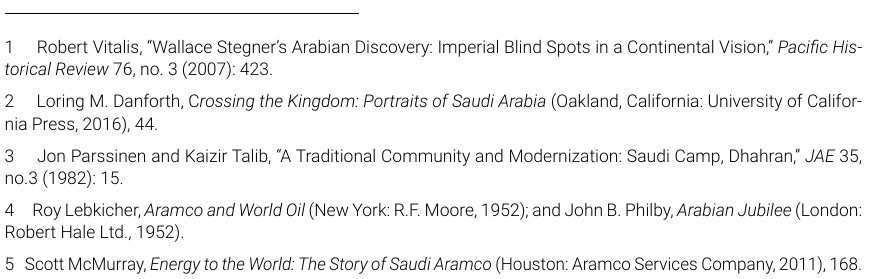
Conditions in the Saudi camps. Left: Saudi camp in Dhahran. Source: Photograph by Fahmi Basrawi included in Munira Khayyat, Yasmine Khayyat, and Rola Khayyat, “Pieces of Us: The Intimate as Imperial Archive,” Journal of